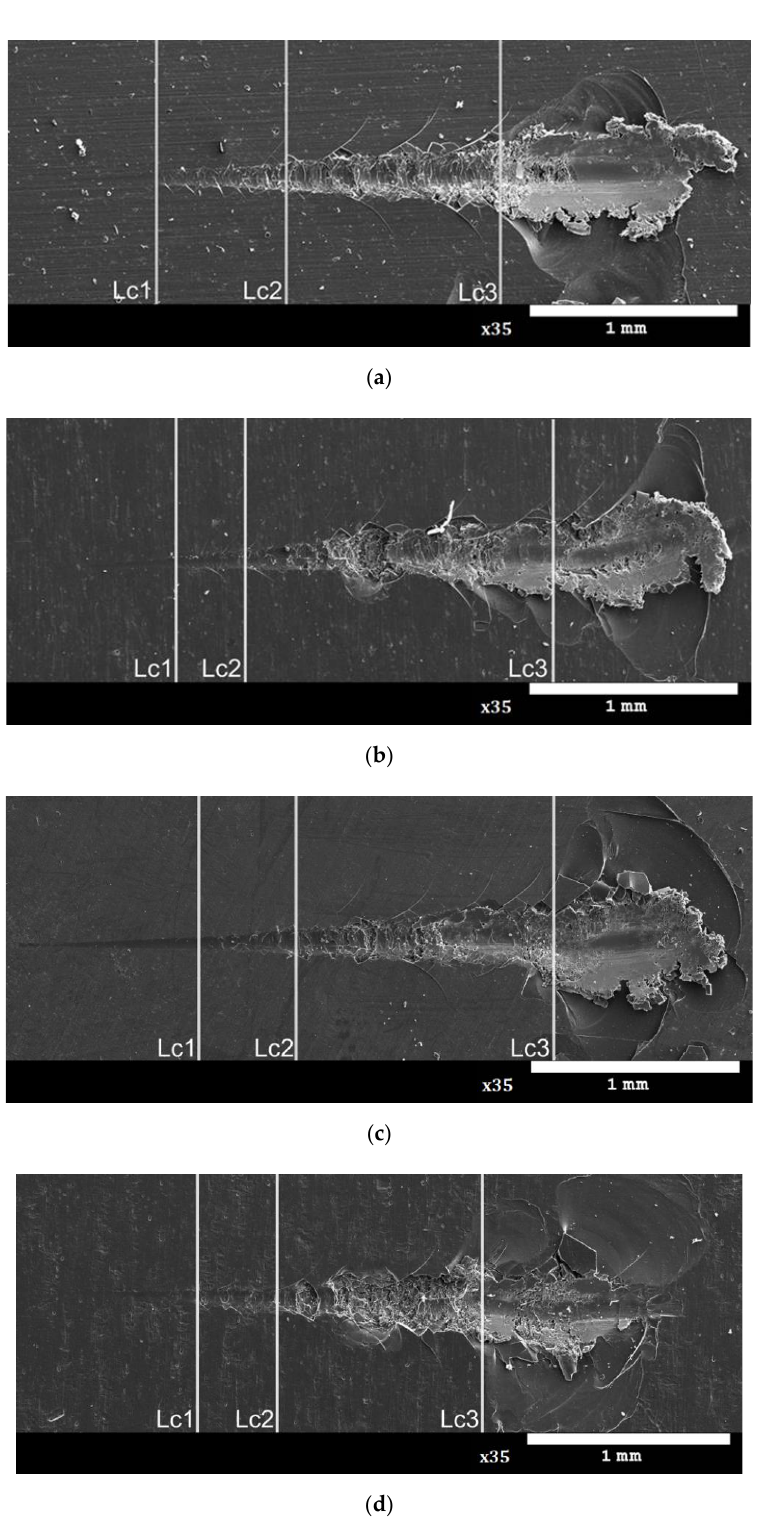
Figure 4. Critical loads determined for layers: ( a ) Sample 1, ( b ) Sample 2, ( c ) Sample 3, ( d ) Sample 4; Lc1 -Hertz cracks, Lc2 -cohesive cracks and Lc3 -adhesive cracks and complete damage of